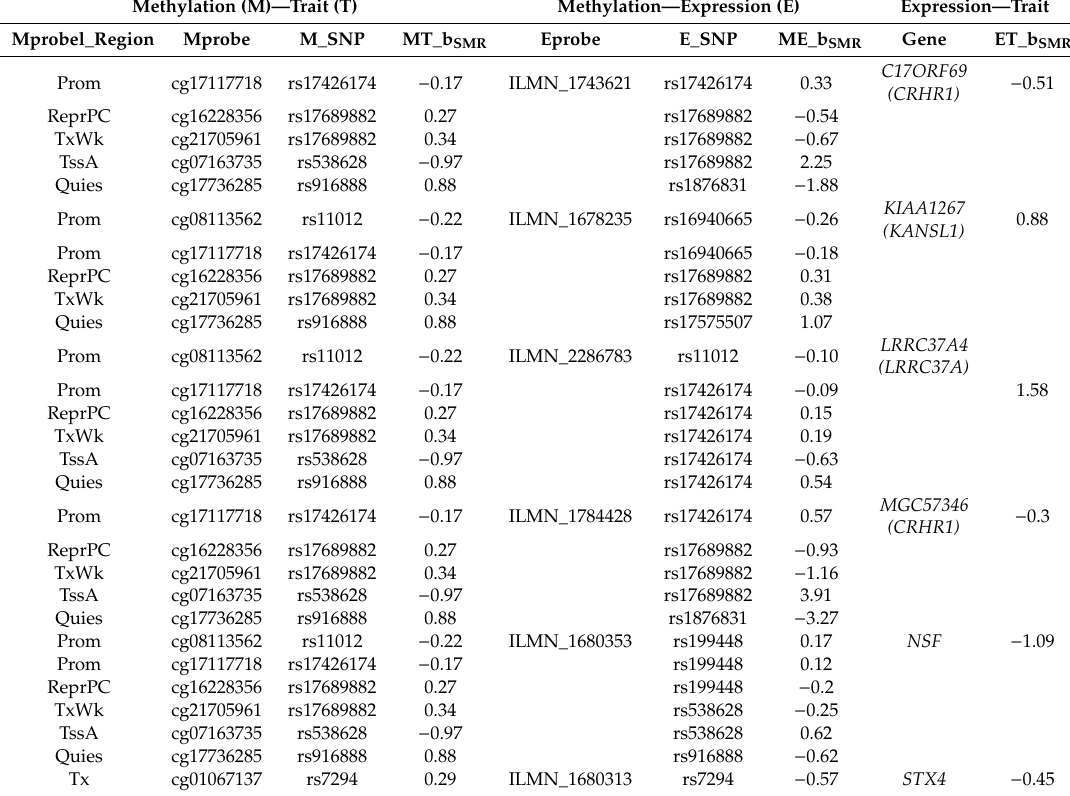
Table 2. Gene loci that pass SMR and HEIDI at the level of DNAm, transcript and trait. Methylation (M)—Trait